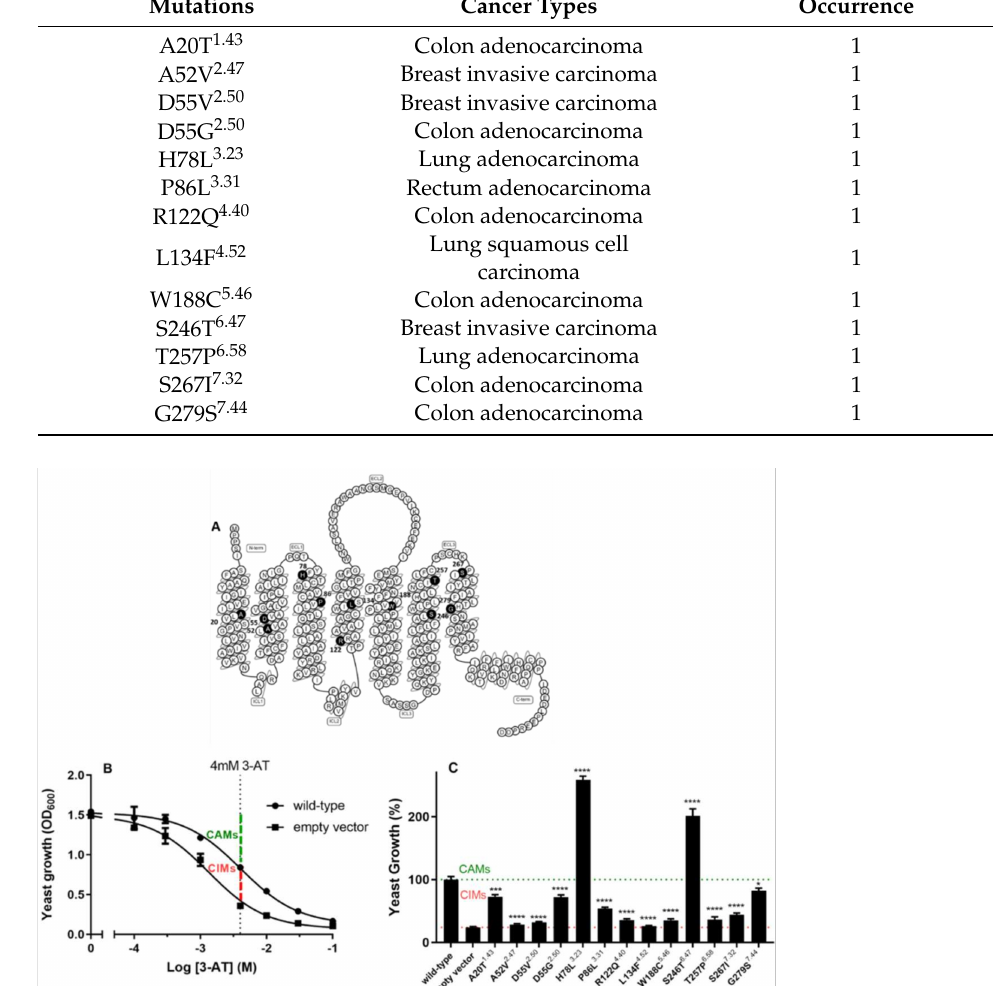
Table 1. List of cancer-related somatic mutations identified from different cancer types.